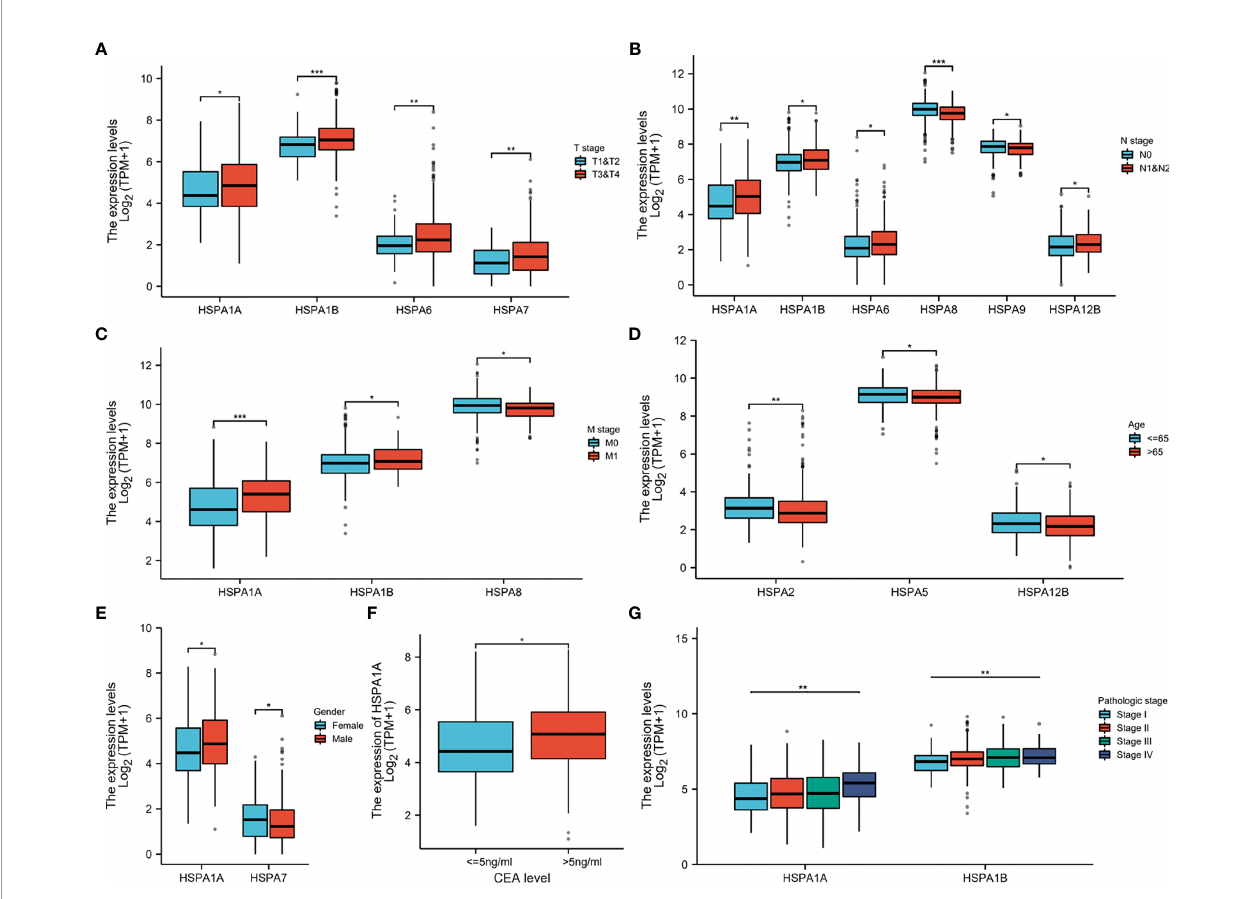
FIGURE 2 | Correlation of HSPA family expression with clinical pathological characteristics in colon cancer. (A) Correlation of HSPA1A, HSPA1B, HSPA6, and HSPA7 expression with T stage. (B) Correlation of HSPA1A, HSPA1B, HSPA6, HSPA8, HSPA9, and HSPA12B expression with N stage. (C) Correlation of HSPA1A, HSPA1B, and HSPA8 expression with M stage. (D) Correlation of HSPA2, HSPA5, and HSPA12B expression with age. (E) Correlation of HSPA1A and HSPA7 expression with gender. (F) Correlation of HSPA1A expression with CEA level (Wilcoxon rank-sum test. * P < 0.05; ** P < 0.01; *** P < 0.001). (G) Correlation of HSPA1A and HSPA1B with pathologic stage (Kruskal – Wallis test. ** P <